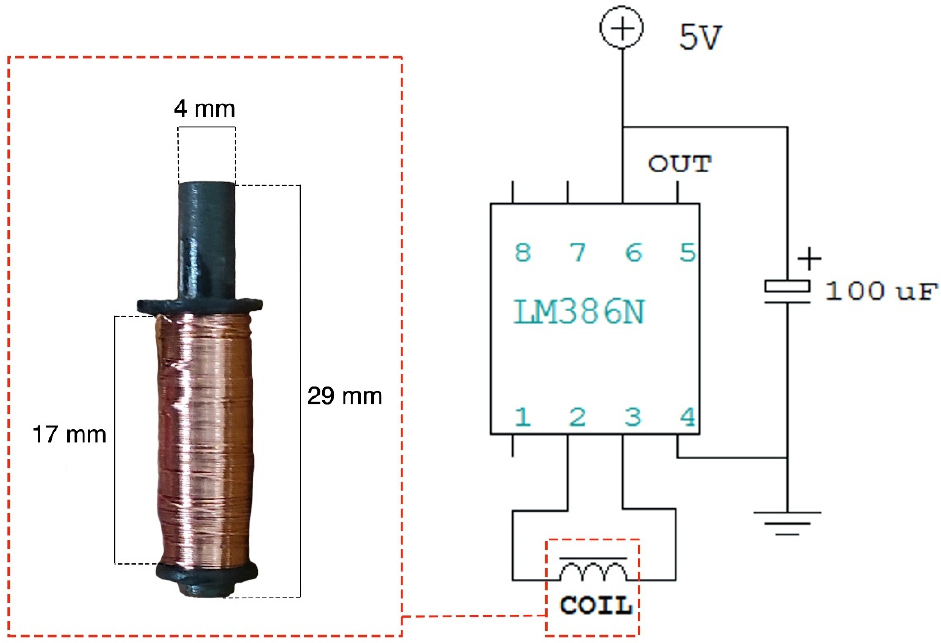
Figure 3. Schematic of the coil conditioning circuit with details on the actual coil used in the exper- iments and its geometrical parameters.